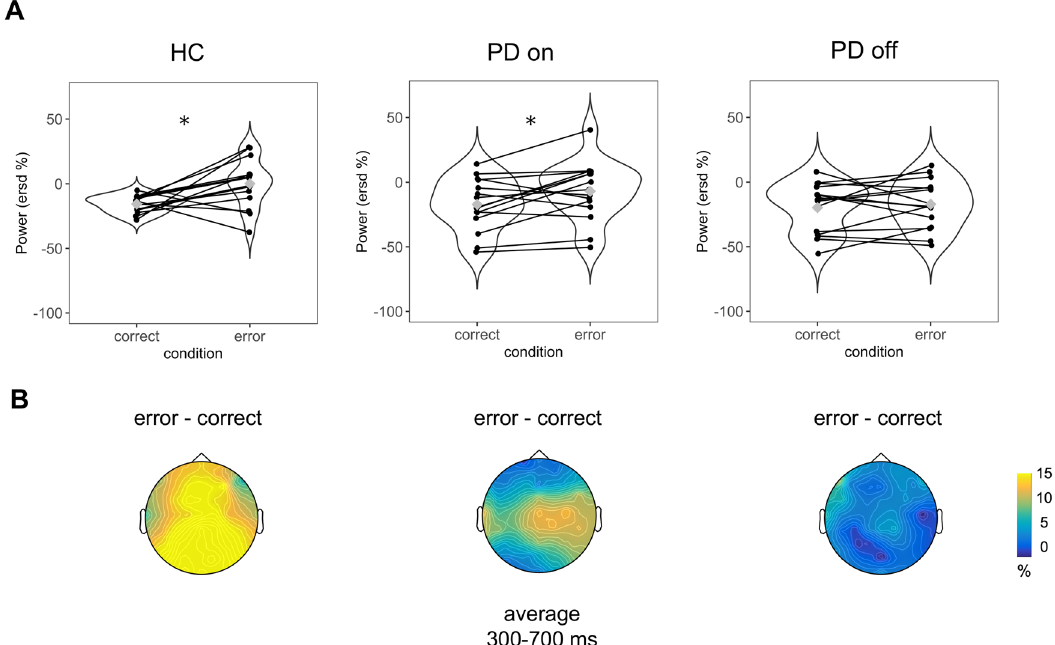
Fig. 4 Graphical representation of theta power (4 – 8.1 Hz) in the three groups on electrode FCz. A Violin plots represent theta activity with correct and incorrect actions. Y -axes represent theta power expressed in relative power change (in %). Grey diamonds in the violin plots denote the mean value; black lines connect individual subject observations (i.e. black points) in the two conditions. B Graphical representation of voltage distribution. The values indicate the difference between incorrect and correct